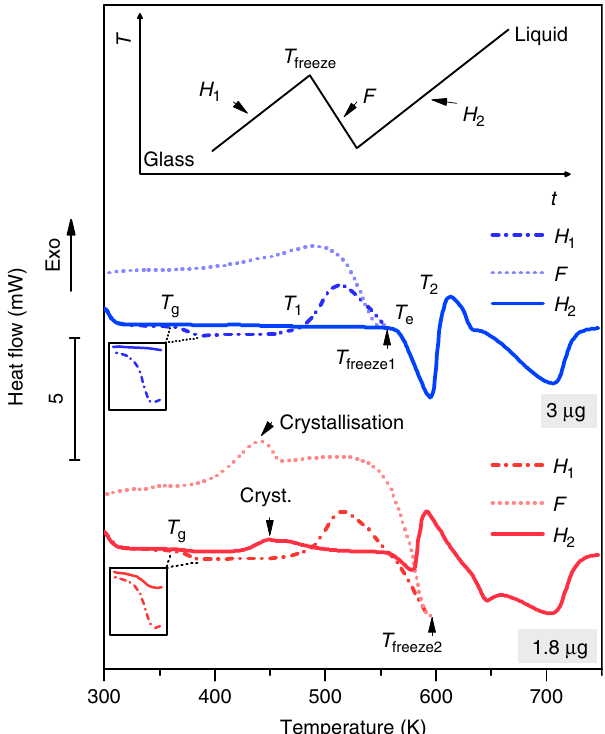
Figure 2 | Freezing non-equilibrium states. Heat flow curves are shown after heating the Au 70 Cu 5.5 Ag 7.5 Si 17 glass with a rate of 2,000Ks (cid:2) 1 ( H 1 ) to T freeze(1,2) and cooling with a rate of 5,000Ks (cid:2) 1 ( F ) and subsequent heating with a rate of 2,000Ks (cid:2) 1 ( H 2 ); the upper image illustrates the applied time–temperature regime. The freezing temperature T freeze1 (blue curves) was chosen to be just above the formation of the metastable crystalline state ( T 1 ), while T freeze2 (red curves) was chosen to be within the metastable liquid. No reactions can be seen upon freezing the metastable crystalline state and no glass transition or crystallization is observed after re-heating with a rate of H 2 ¼ 2,000Ks (cid:2) 1 to T freeze1 . This indicates that the material was mostly crystallized during the first heating step. Upon freezing from T freeze2 partial crystallization is observed, and upon re-heating with H 2 a small glass transition and crystallization event are seen below T freeze2 . This provides evidence that a metastable liquid has formed during the endothermic event at T e